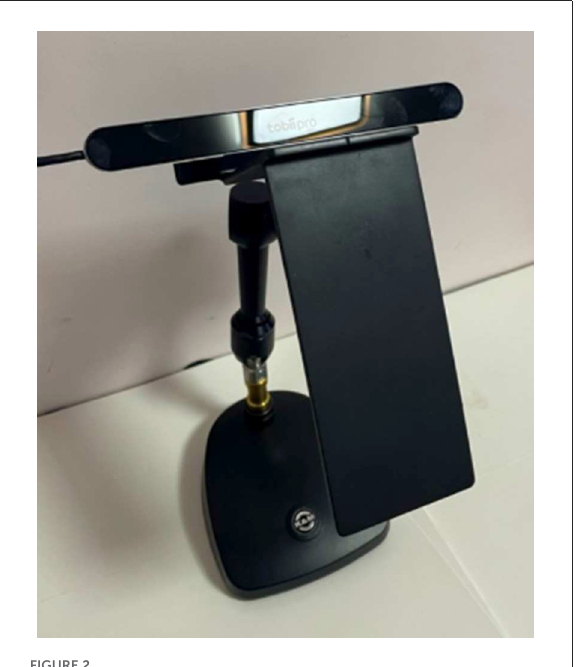
FIGURE2 Tobii Pro Nano with mobile testing